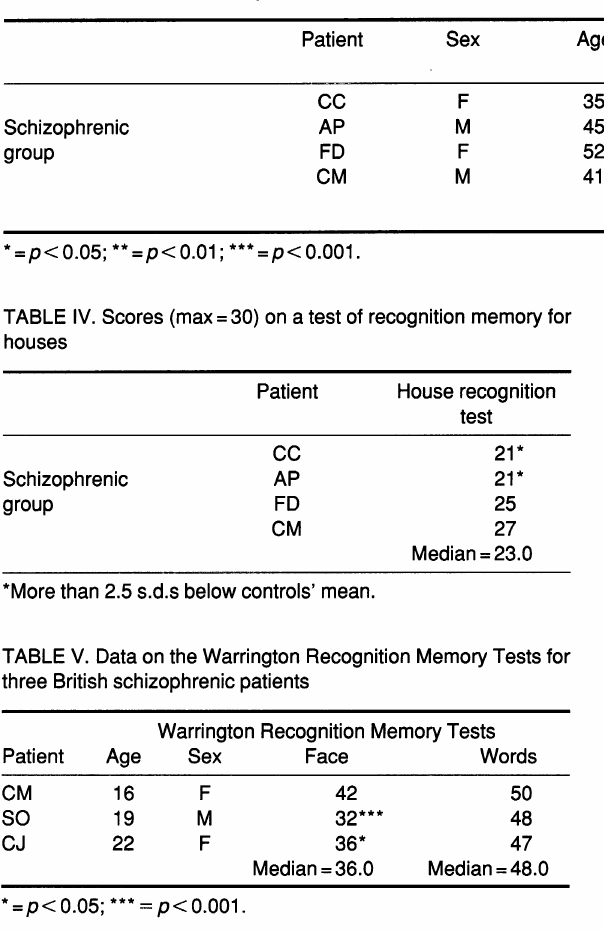
TABLE III. Scores on Warrington RMT faces and RMTwords for four French schizophrenic patients